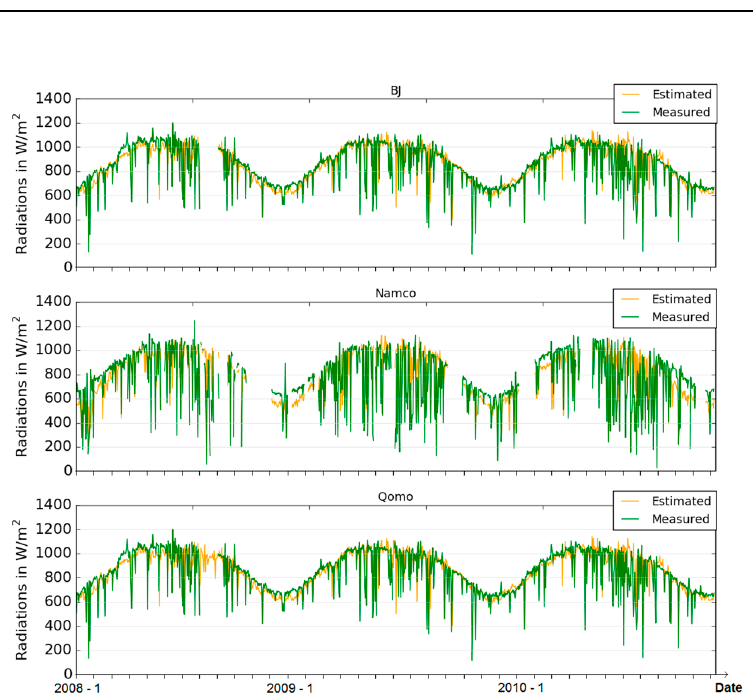
Figure 8. Time series of estimated (yellow) and measured (green) instantaneous solar incident radiations for each of the pixel used for the comparison with the ground stations of BJ, NamCo, and Qomolangma (Qomo).